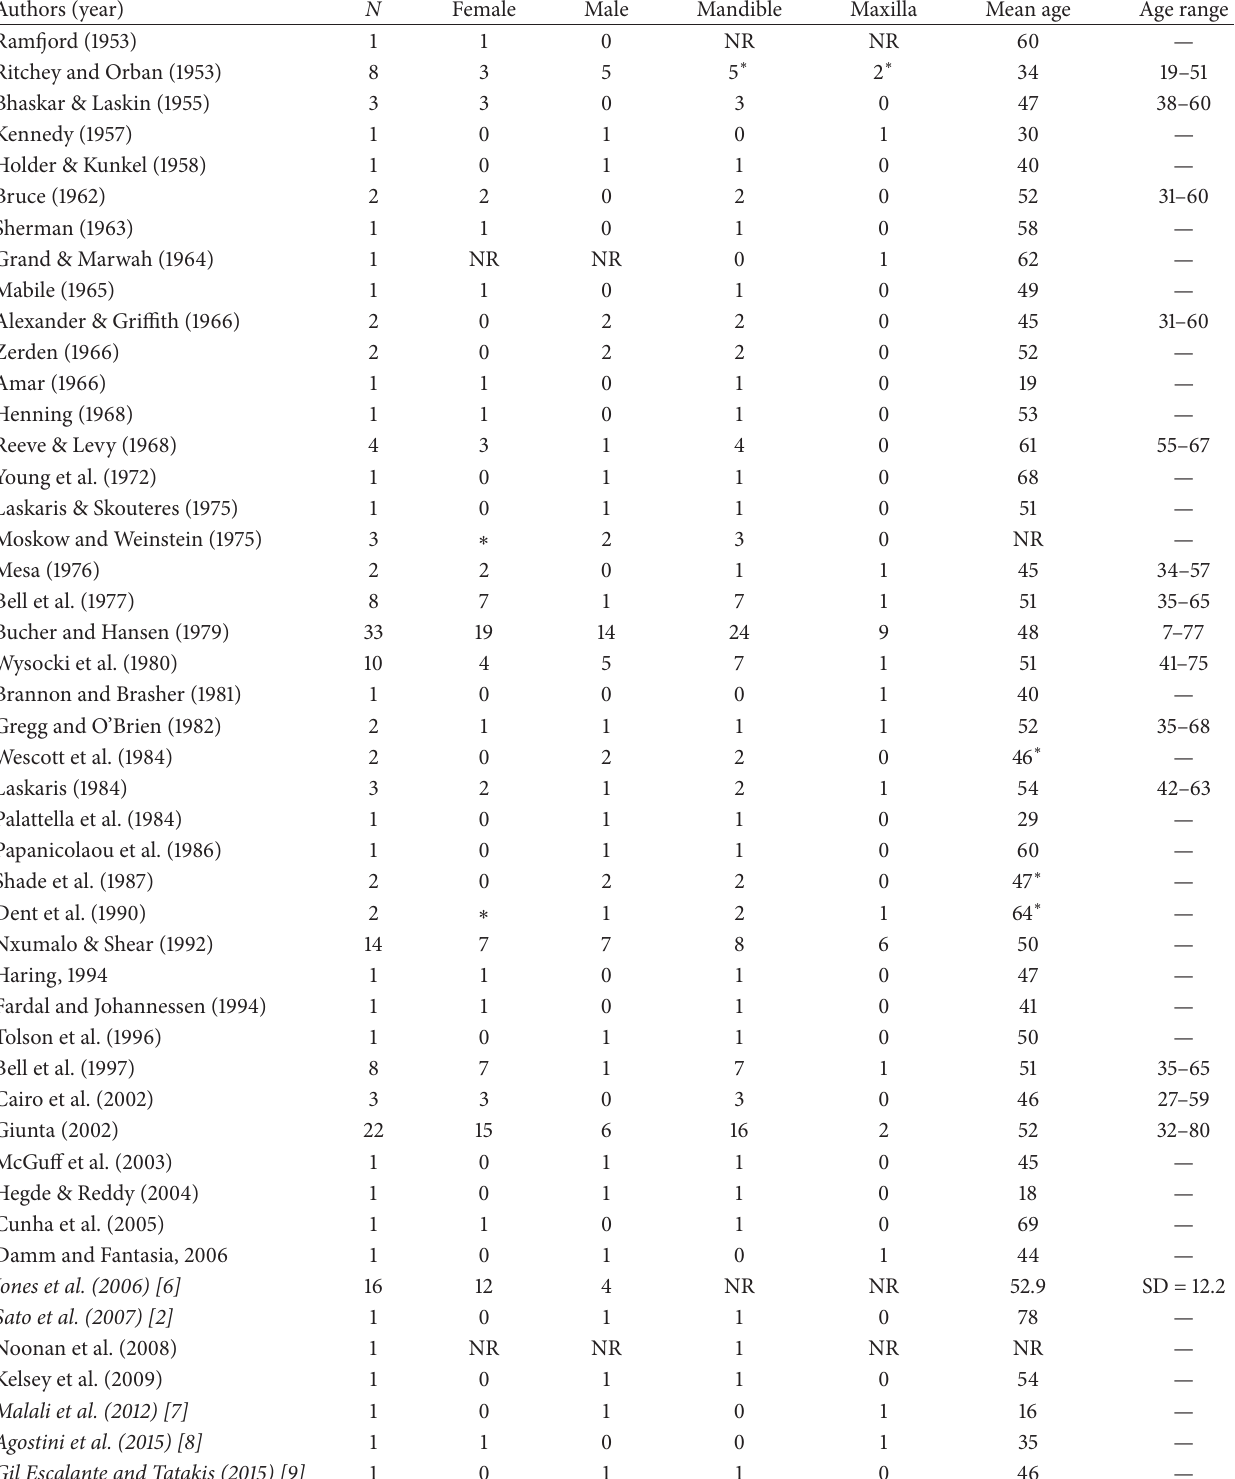
Table adapted from Giunta 2002 [5] and Kelsey et al. 2009 [10] and references therein. References not cited in Giunta 2002 and Kelsey et al. 2009 are shown in italics. ∗ I nformation missing on 1 or more cases. NR = not reported. SD = standard